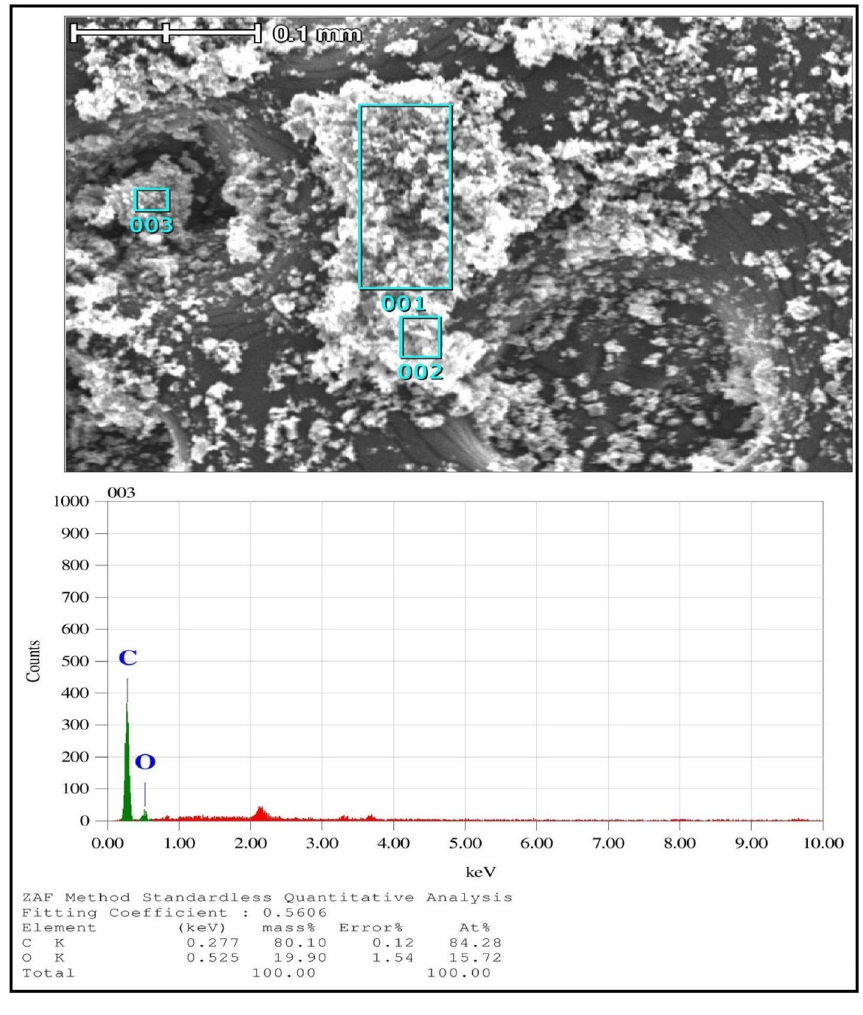
Figure 4. EDS analysis of